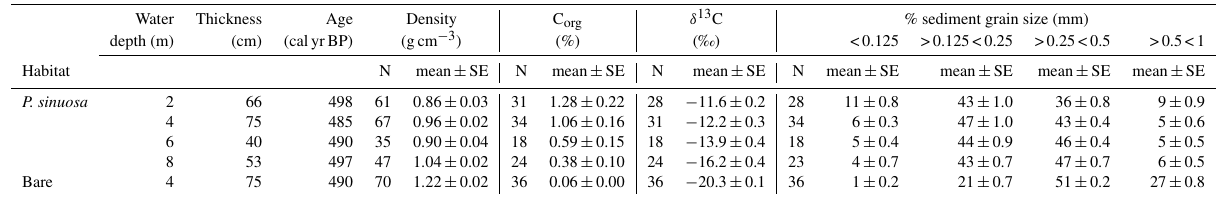
Table 1. Average ± standard error (SE) density (in gcm − 3 ) , C org content (in %), δ 13 C signatures and sediment grain-size content at Cockburn Sound (normalized for ca. 500-year-old deposits).